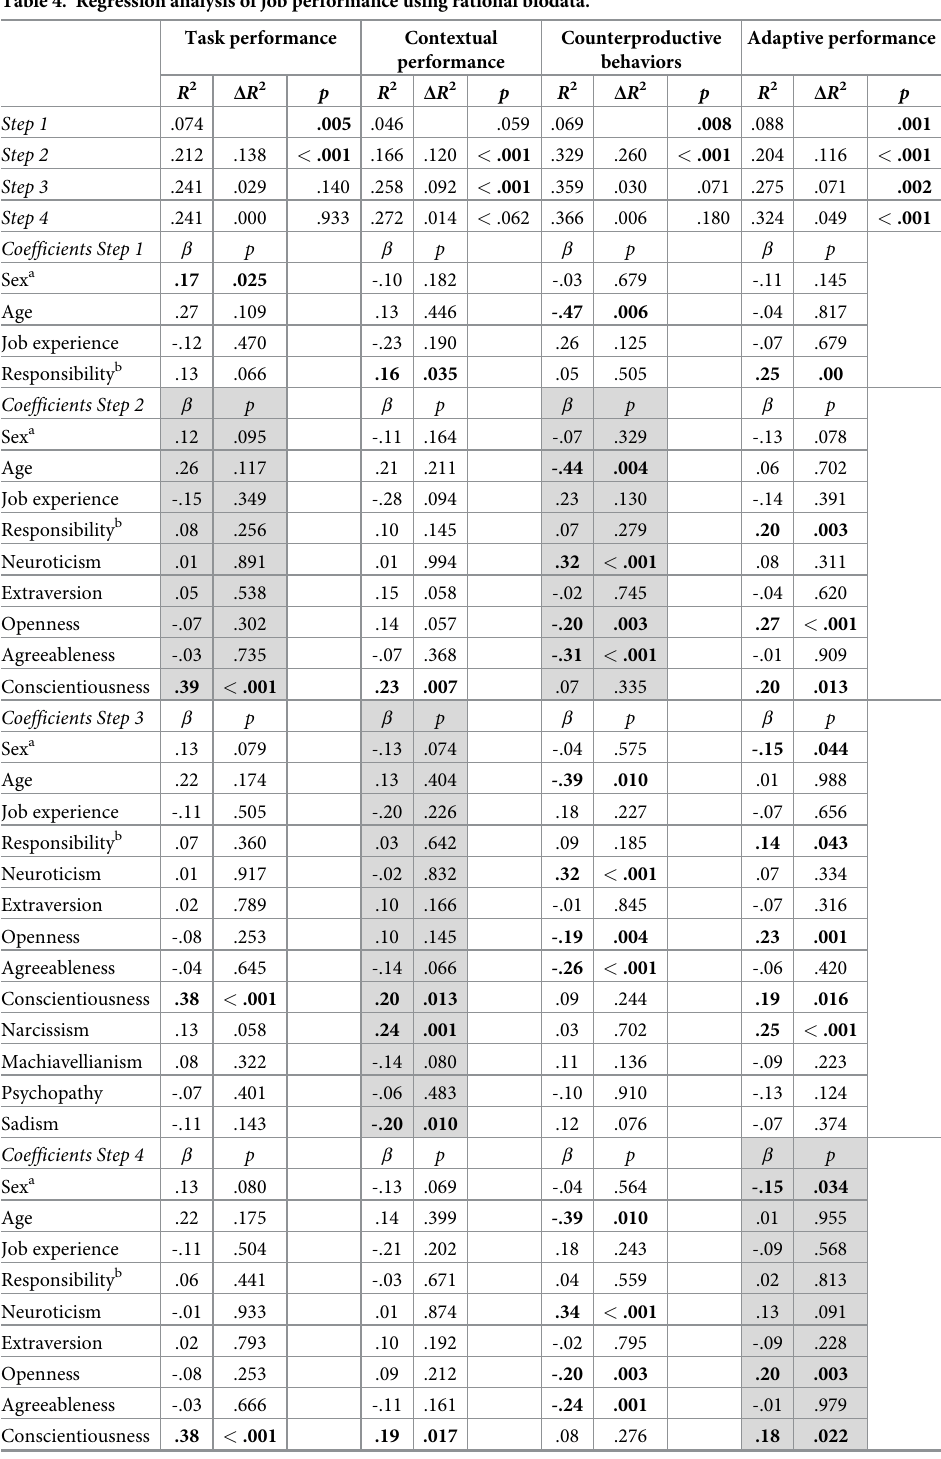
Table 4. Regression analysis of job performance using rational